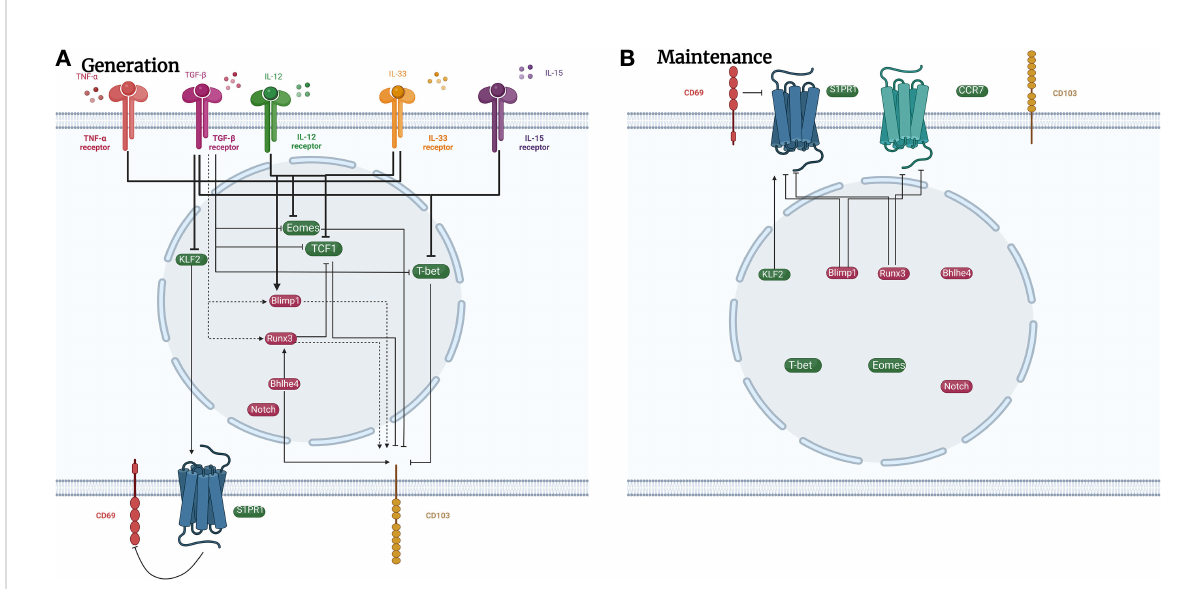
FIGURE 3 Signaling pathways in regulating the generation and maintenance of pulmonary CD8 + TRM cells. Plenty of signaling pathways regulate the development of CD8 + TRM cells. (A) TNF- a , IL-33, TGF- b , and IL-15 promote the development of CD8 + TRM cells by increasing the expression of transcription factors such as Runx3, Blimp1, and Bhlhe4, and decreasing the expression of transcription factors such as Eomes, T-bet, and KLF2. (B) Transcription factors such as Blimp1 and Runx3 inhibit the expression of cell surface receptors CCR7 and S1PR1 to maintain the presence of CD8 + TRM cells in the lungs. Cell surface marker CD69 can also decrease the expression of S1PR1 to sustain CD8 + TRM cells. green icons: inhibitory roles; red icons: facilitating roles. dotted line: possible